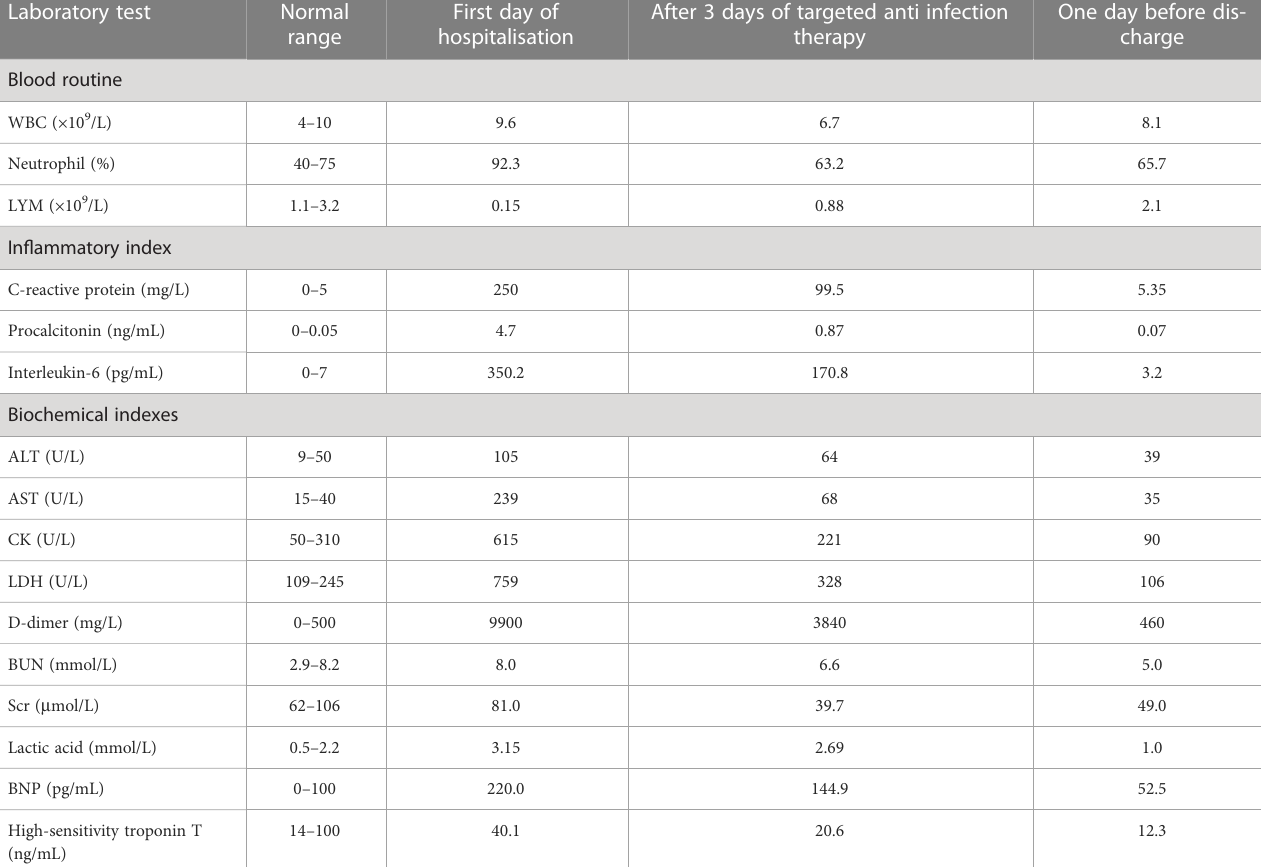
TABLE 1 Results of laboratory tests of the patient at different